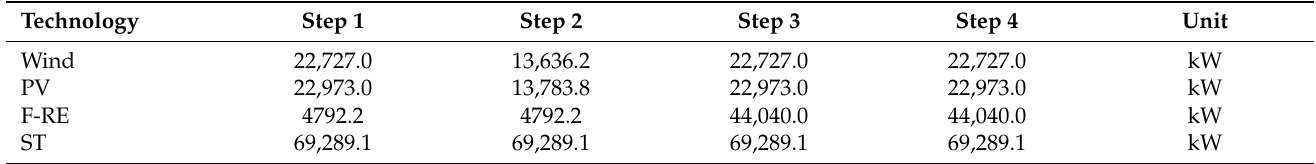
Table 11. Installed capacity in kW in the optimization scenarios.